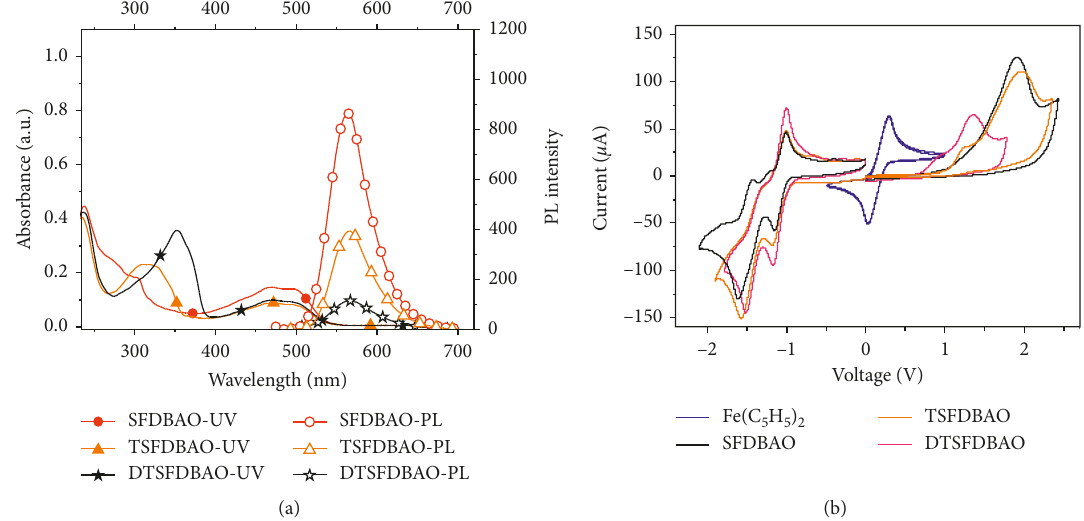
Figure 4: The photophysical and electrochemical properties of SFDBAO. (a) UV-vis electronic absorption spectra and photoluminescence spectra. (b) Reductive and oxidative cyclic voltammograms, 0.1M n-Bu 4 NPF 6 in THF (reduction) and 0.1 M n-Bu 4 NPF 6 in CH 2 Cl 2 (oxidation), were used as supporting electrolytes. A platinum sheet electrode was used as the working electrode; the scanning rate was 100mV/s, where E + (Fc/Fc) is about 0.03